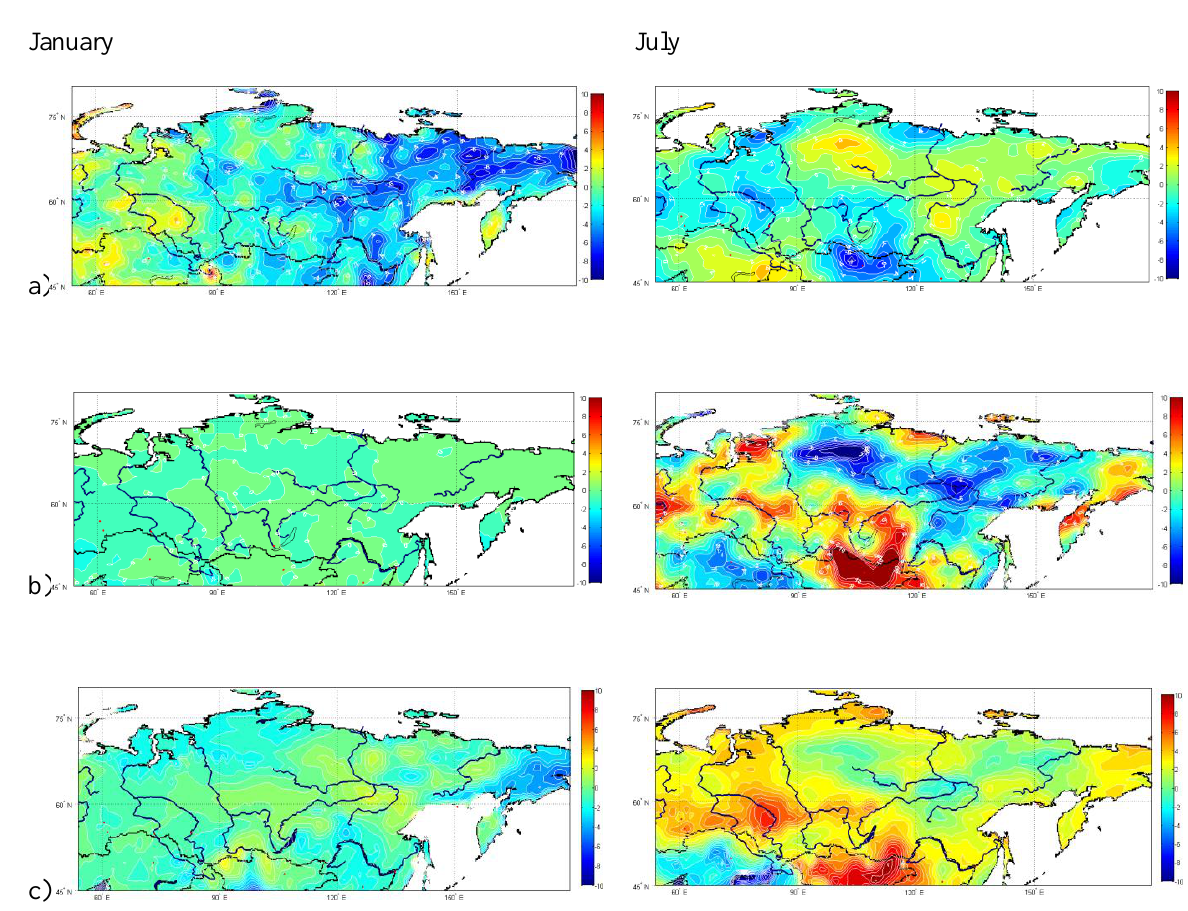
Fig. 5. The spatial variability of total cloud cover trend ( TC , %/decade) (a) . Downward shortwave radiation trend at the surface ( Q ↓ s , Wm − 2 /decade) (b) and effective radiation trend ( E eff , Wm − 2 /decade) (c) over ATR for January and July by JRA-25 for the period of Figure 5. The spatial variability of total cloud cover trend ( TC . %/decade) (a). downward 2 shortwave radiation trend at the surface ( Q ( E . W/m 2 /decade) (c) over ATR for January and July by JRA-25 for the period of 1979-4 eff 2008. 5